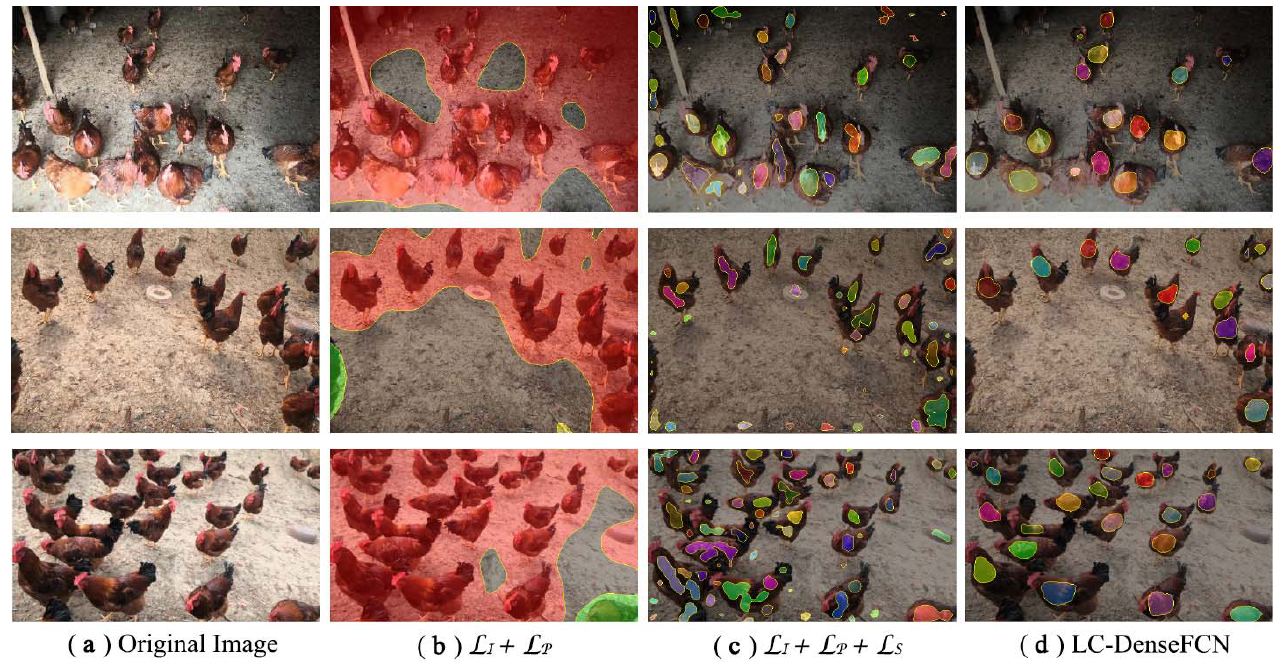
Figure 4. Qualitative results of LC-DenseFCN trained with different terms of the proposed loss function. ( a ) Test images obtained from our test dataset. ( b ) Prediction results using only image-level and point-level loss terms. ( c ) Prediction results using image-level, point-level and split-level loss terms. ( d ) Prediction results trained with the full proposed loss function.